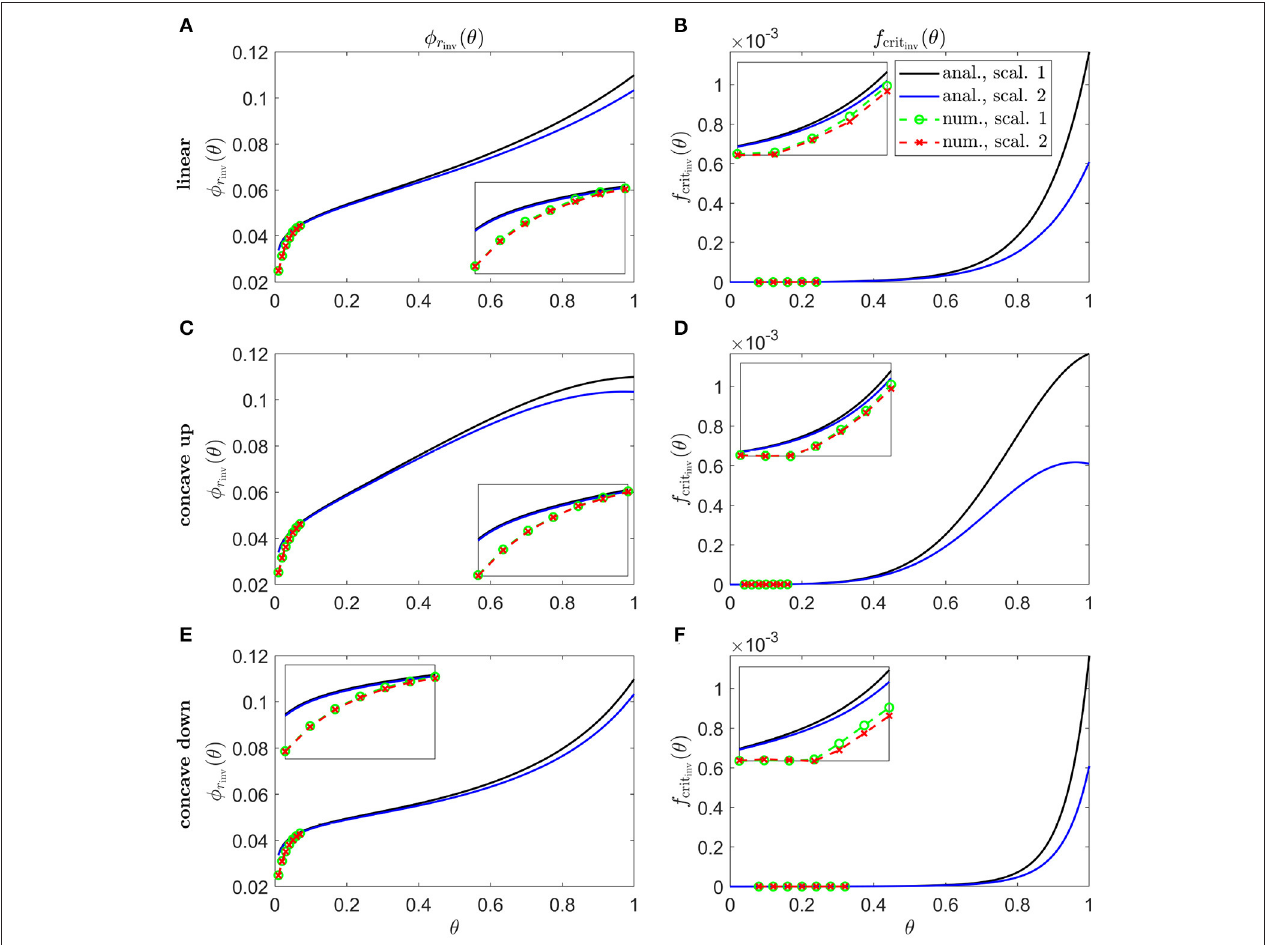
FIGURE 7 | Inverse mutation-induced rod degeneration rate and TF threshold concentration—Pattern 1A target cone degeneration profiles. (A,C,E) inverse mutation-induced rod degeneration rate, φ r ( θ ) ( f crit = 3 × 10 − 5 ); (B,D,F) inverse TF threshold concentration, f crit ( θ ) ( φ r = 7.33 × 10 − 2 ). (A,B) linear target cone inv inv degeneration profile, t degen ( θ ); (C,D) concave up quadratic t degen ( θ ) profile; (E,F) concave down quadratic t degen ( θ ) profile. The solid black and dashed green curves correspond to Scaling 1 ( α = 7.01 × 10 4 and β = 1.79 × 10 6 ), while the solid blue and dashed red curves correspond to Scaling 2 ( α = 7.01 × 10 2 and β = 1.79 × 10 4 ). The black and blue solid curves are analytical approximations to the inverses, obtained by plotting Equations (7) and (10), respectively, (A,C,E) and Equations (8) and (11), respectively, (B,D,F) . The green and red dashed curves are numerical inverses, obtained by using the Matlab routines fminsearch (A,C,E) , and patternsearch (B,D,F) to calculate the φ r and f crit profiles for which the contour described by p c ( θ , t ) / ˜ p c ( θ ) = 0.99 matches the target cone degeneration profile, t degen ( θ ). Equations (1–5) were solved at each iteration using the method of lines, with 26, 51, or 101 mesh points. Insets show magnified portions of each graph. Numerical inverses are calculated and plotted only at those locations (eccentricities) where the analytical inverse fails to generate a t degen ( θ ) profile matching the target profile. Inverses are monotone increasing functions for both scalings in (A, B, E, F) , and for Scaling 1 in (C,D) while the inverses increase initially for Scaling 2 before reaching a maximum and decreasing toward the ora serrata ( θ = 1) in (C,D) . Numerical solutions reveal lower values of the inverses near the fovea ( θ = 0) than the analytical approximations suggest. Cone degeneration profile formulas and parameters are given in Table 3 . Remaining parameter values as in Table 2